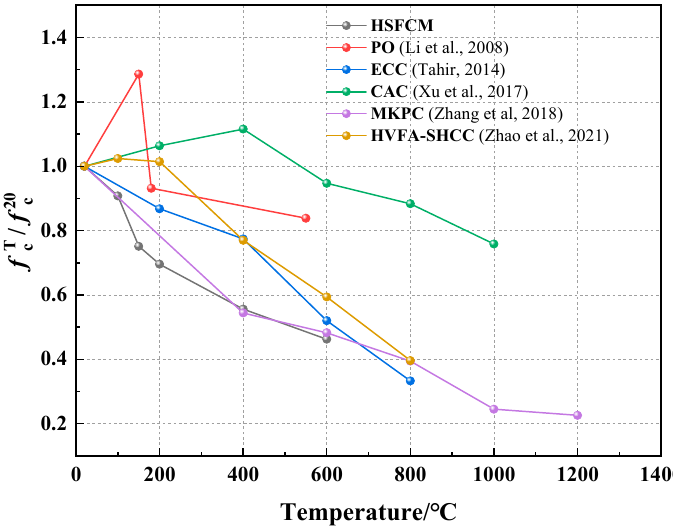
Figure 9. Comparison of compressive strength of several cementitious